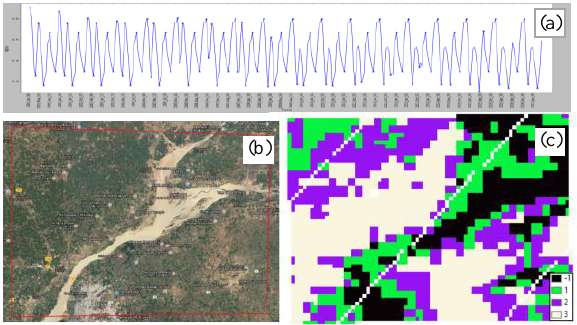
Figure 3: (a) Time Series NDVI for Deesa; (b) Zoomed-in Google Image of the area; (c) Re-classified map showing pixels having 1, 2 and 3 cropping cycles (-1 shows no vegetation) Growth period